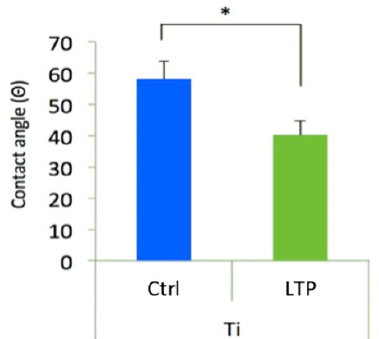
Figure 3. Measurement of the contact angle on each treated surface. Contact angle ( θ ) was considered the index of surface wettability, indicated by the angle formed by a water droplet on the disk surface. Quantitative analysis indicated that the surface wettability of low-temperature plasma (LTP)–treated (LTP-Ti) disks was improved in comparison with the control (Ctrl-Ti) disks (autoclaved only). * p < 0.05.